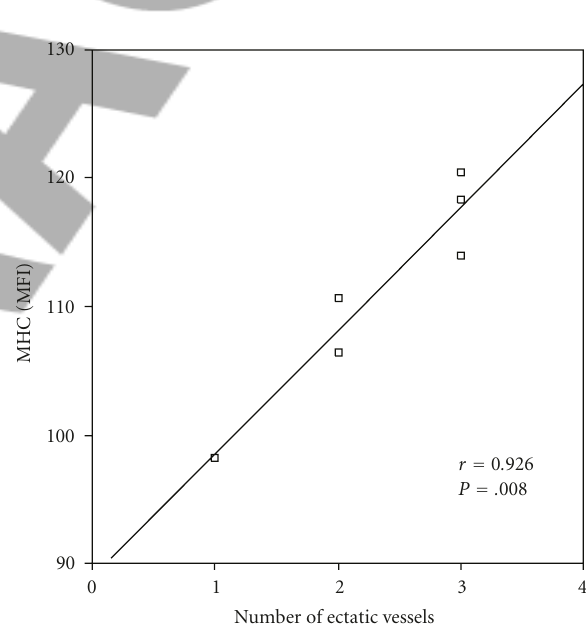
Figure 4: The graph showing the relationship between the number of ectatic vessels and the expression level of MHC Class II. r : Spearman’s rho correlation coe ffi cient. MFI: mean fluorescence intensity. MFI: mean fluorescence